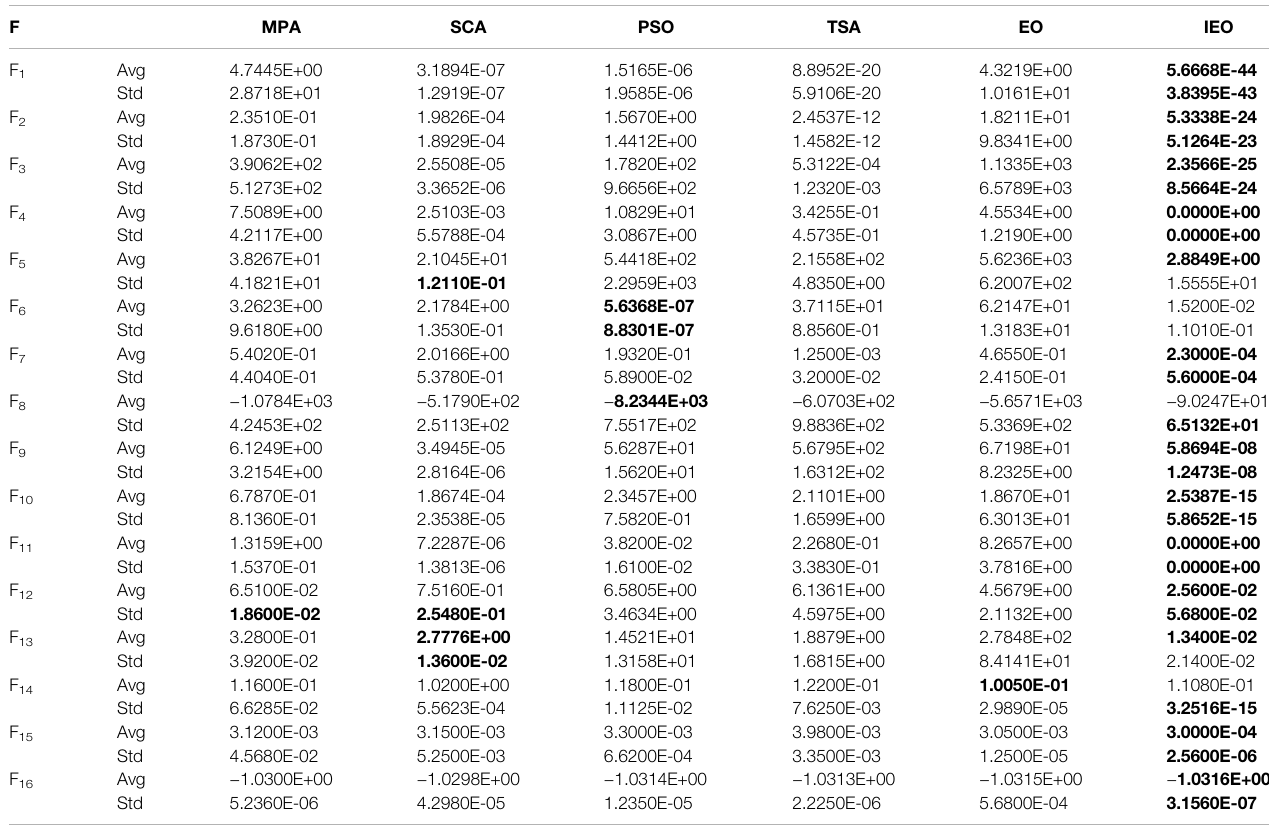
TABLE 3 | Experimental comparison results.